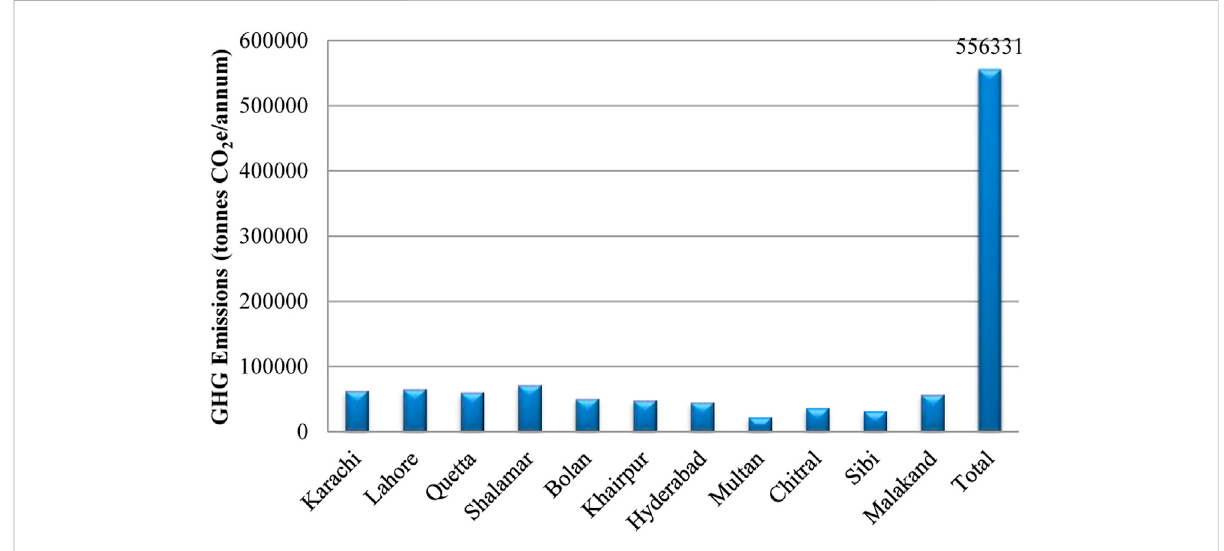
FIGURE 3 Total annual GHG emissions (CO 2 e) from PNSC fl eet based on fuel consumption (VLSFO).